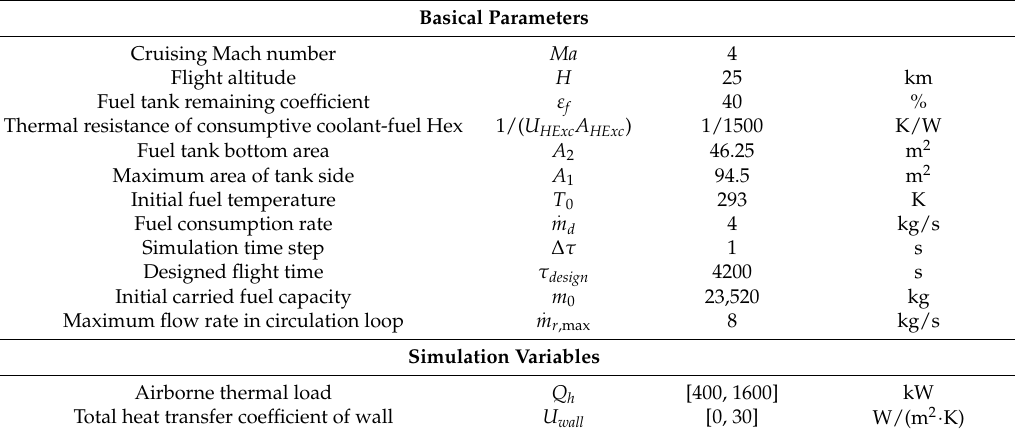
Table 3. Simulation conditions. Basical